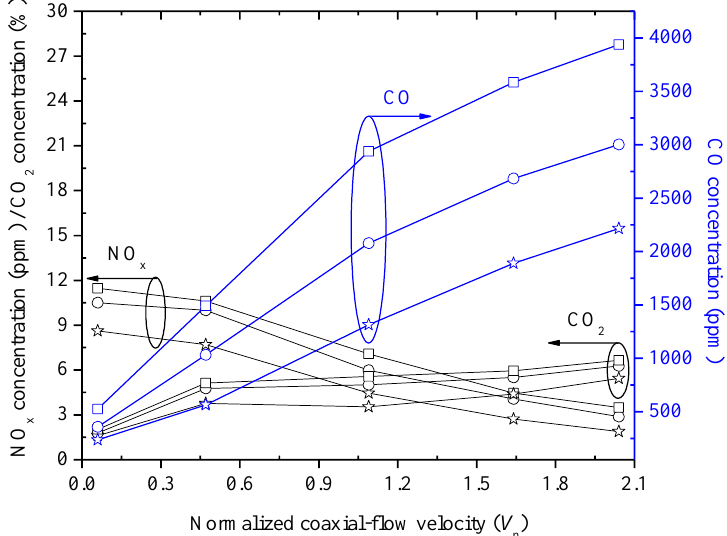
Figure 7. NO x /CO 2 /CO emissions versus CO 2 -O 2 coaxial-flow velocity ( ☆ : β = 21%; О: β = 24%; □ : β = 27%).